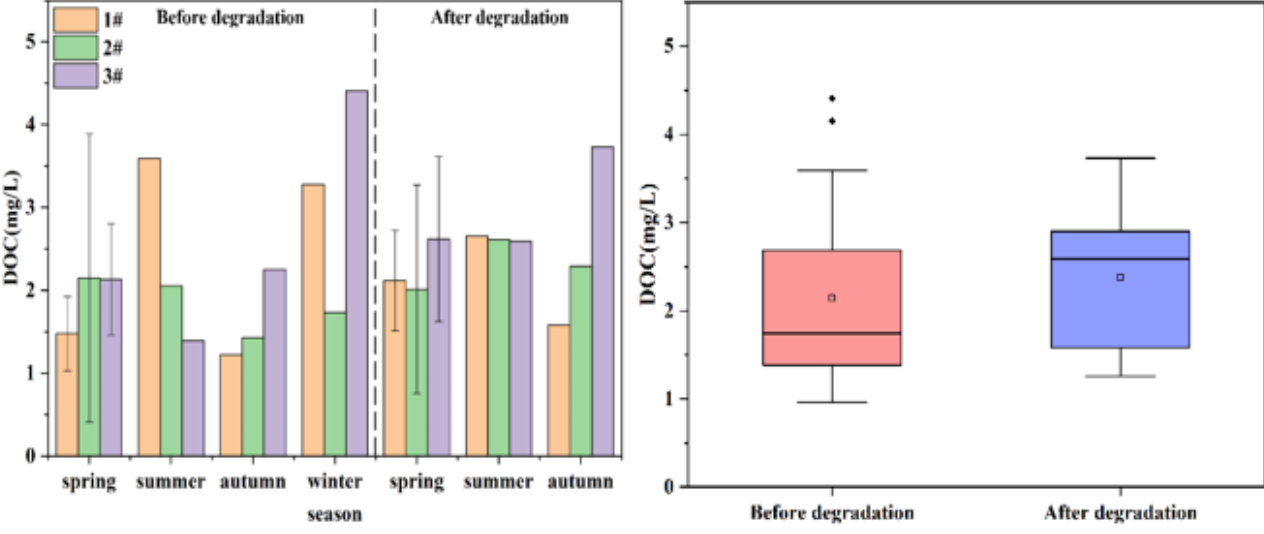
Figure 2. Spatial and temporal changes in DOC in Ten Mile River before and after degradation. Right panel: The box-plot consists of five numerical points: minimum observation (bottom edge), 25% quantile (Q1), median, 75% quantile (Q3), and maximum observation (top edge).